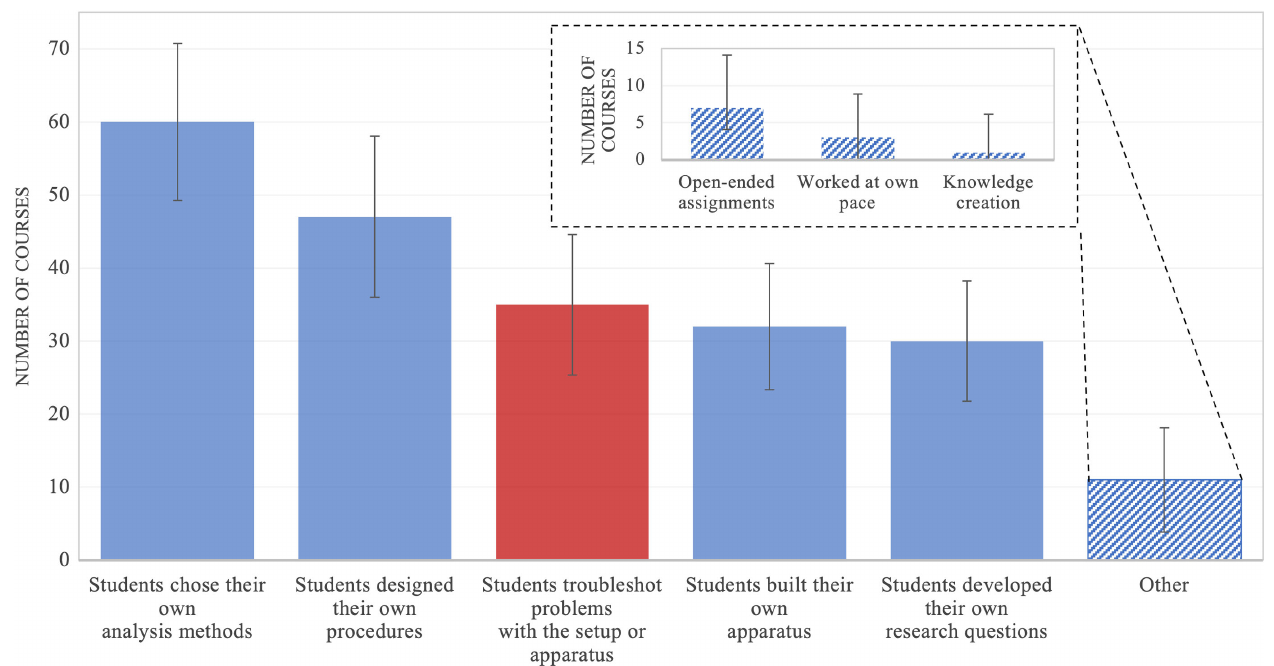
FIG. 7. Instructor reported student choice and self-regulated learning opportunities used after the transition to remote instruction in Spring